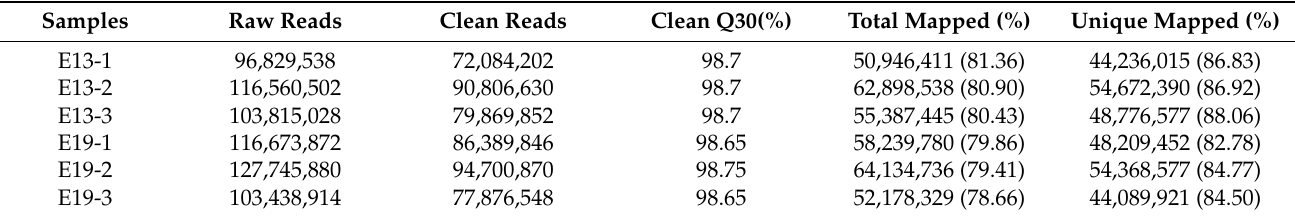
Table 2. Summary of RNA-seq analysis of E13 and E19 duck breast muscle.